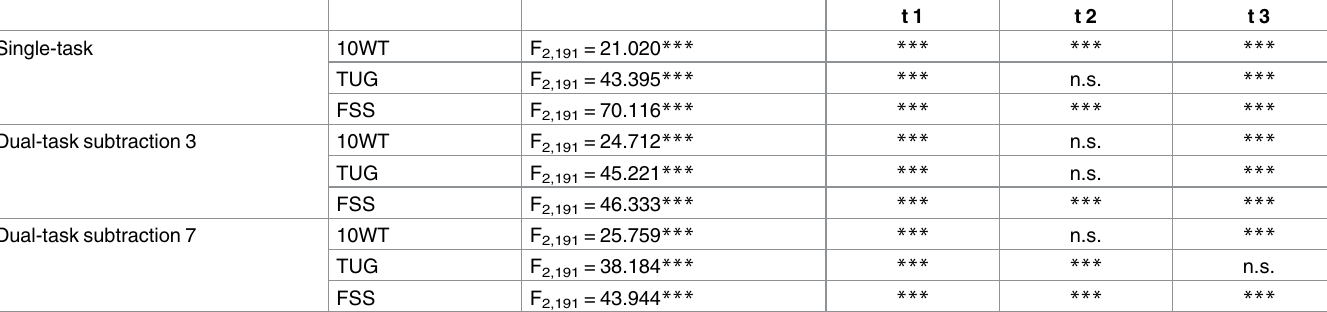
Table 5. ANCOVAsand post hoc results of interaction Age ×